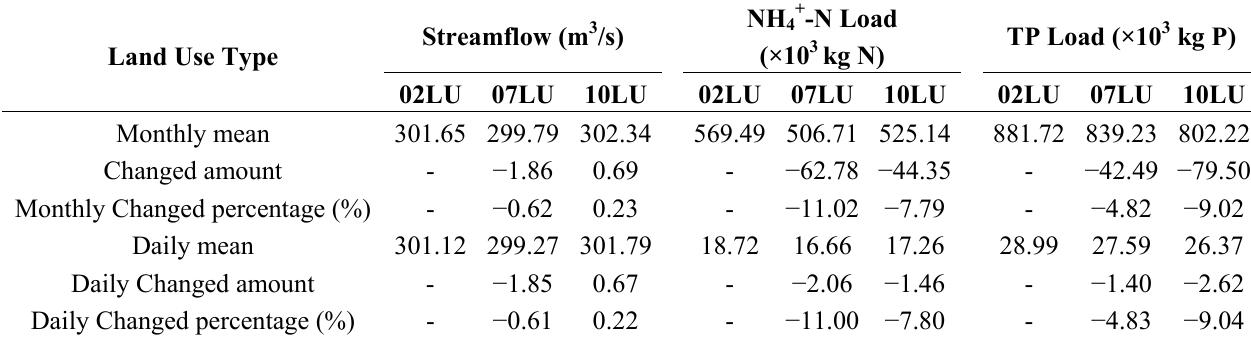
Table 5. Comparison of streamflow, NH 4+ -N, and TP simulations under the three points in time. NH 4+ -N Load Streamflow (m 3 /s) TP Load (×10 3 kg P) (×10 3 kg N) Land Use Type 02LU 07LU 10LU 02LU 07LU 10LU 02LU 07LU 10LU Monthly mean 301.65 299.79 302.34 569.49 506.71 525.14 881.72 839.23 802.22 Changed amount - − 1.86 0.69 - − 62.78 − 44.35 − 42.49 − 79.50 Monthly Changed percentage (%) - − 0.62 0.23 301.12 299.27 301.79 Daily Changed